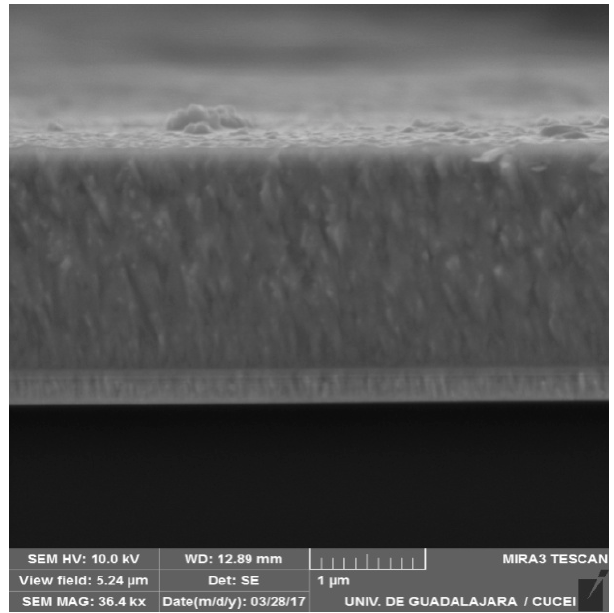
Figure 1. SEM image of the cross section of the TaZrN layer deposited on Si substrate.